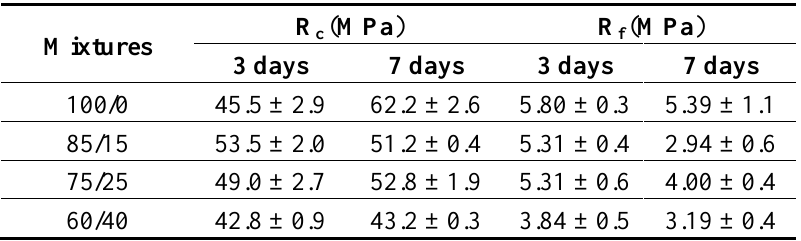
Table 3. Mechanical strengths of mortars cured at 65 °C.